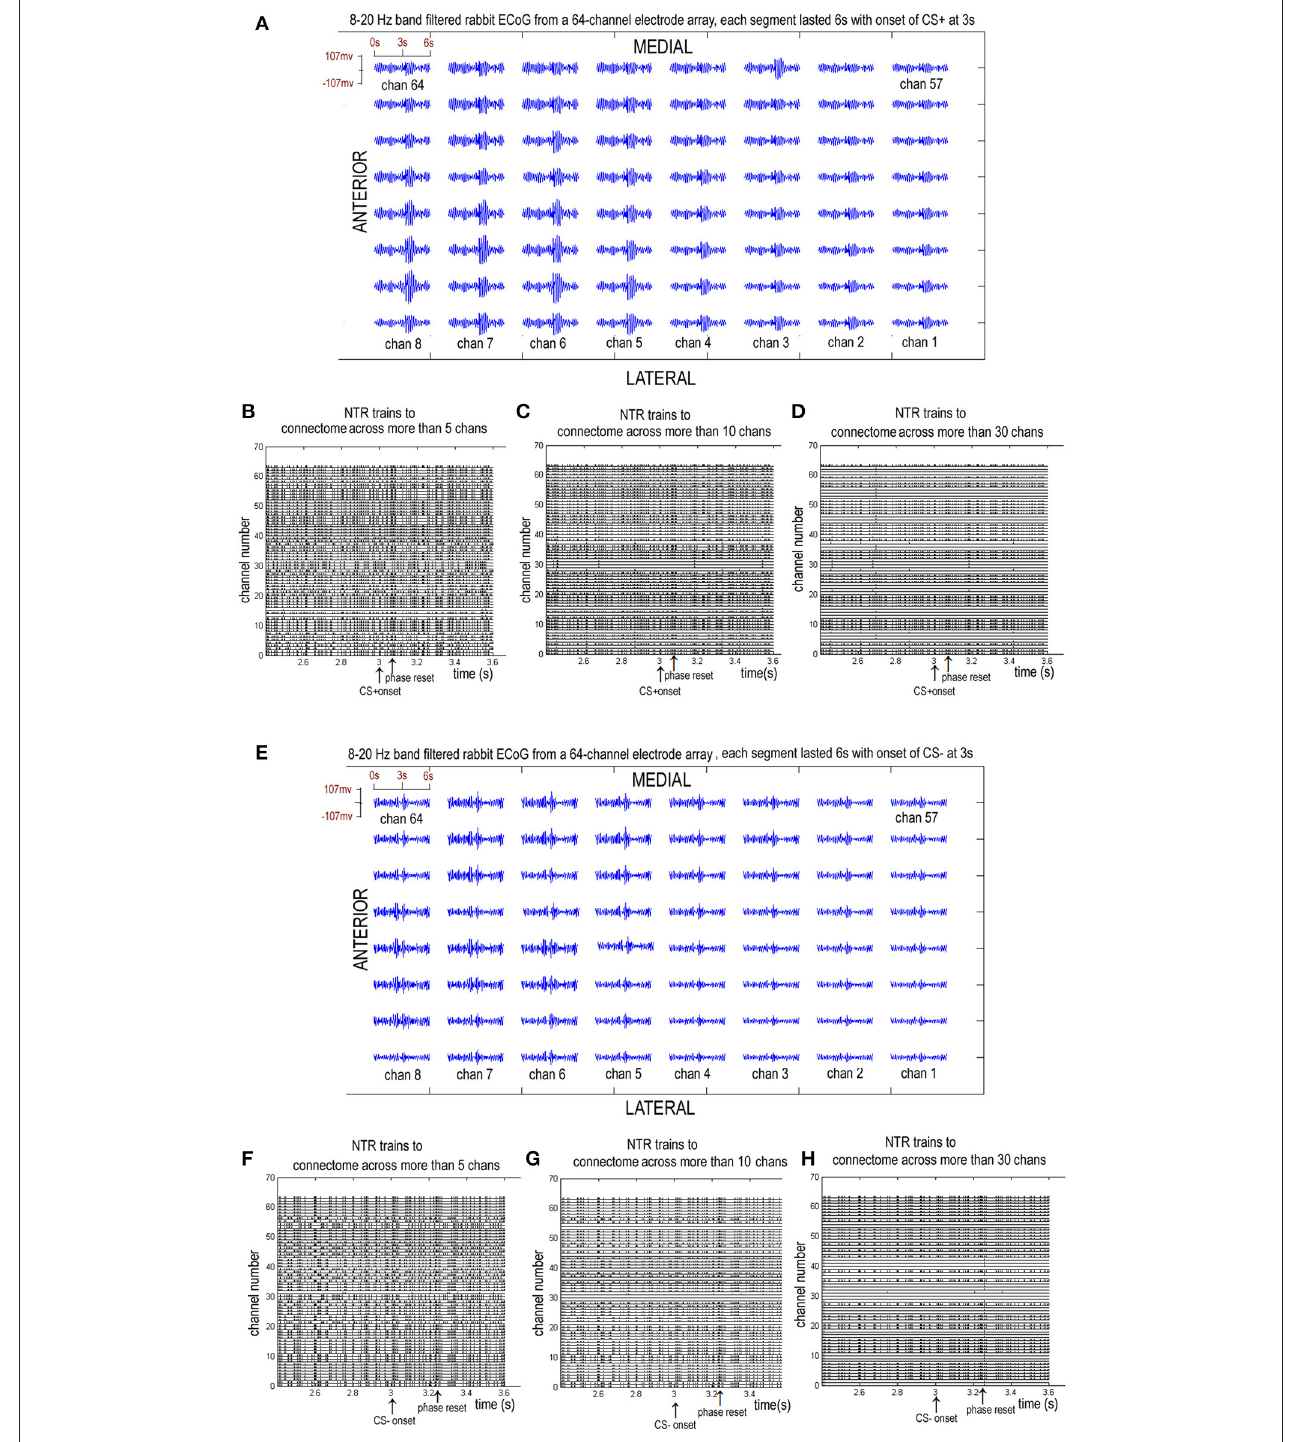
FIGURE 3 | Eight to twenty hertz band filtered rabbit ECoGs from a chronically implanted 64-channel electrode array and the sorted NTR trains corresponding to connectome across more than 5, 10, and 30 channels. (A–D) from a CS